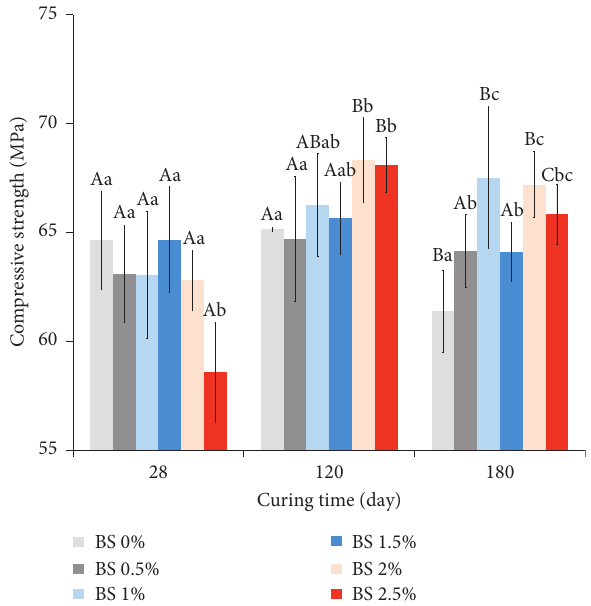
Figure 1: Effect of biosurfactant (BS) concentration on the compressive strength of mortars at curing periods of 28, 120, and 180 days. Tukey’s HSD test was performed to differentiate the significance of treatment. Statistically significant differences are noted by different letters. Capital letters indicate significant dif- ference among curing times at the same biosurfactant concen- tration, and lowercase letters indicate significant difference among concentrations at the same curing time.